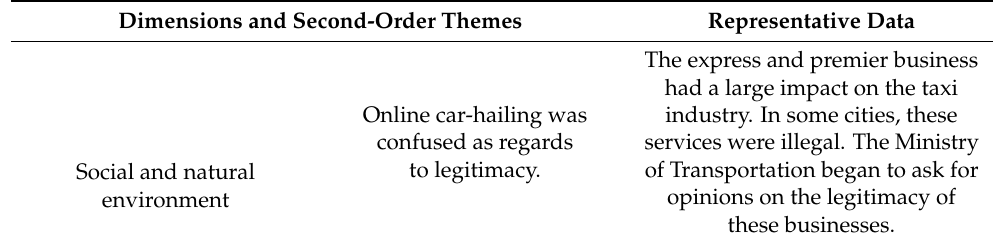
Table 5. Dimensions, themes, and data in the phase of pressure from the